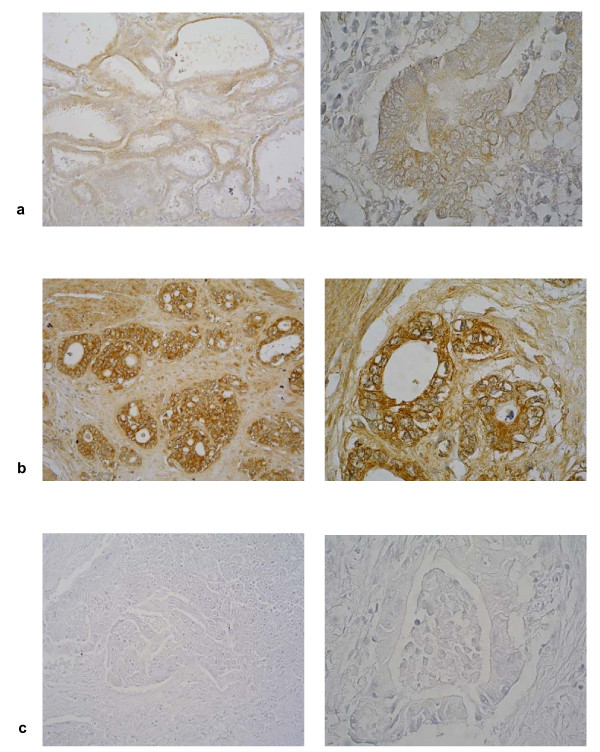
a-c. CXCR4-expression in adenocarcinoma with weak (CXCR4w) (a) and strong (CXCR4s) (b) staining intensity compared to negative control (c).